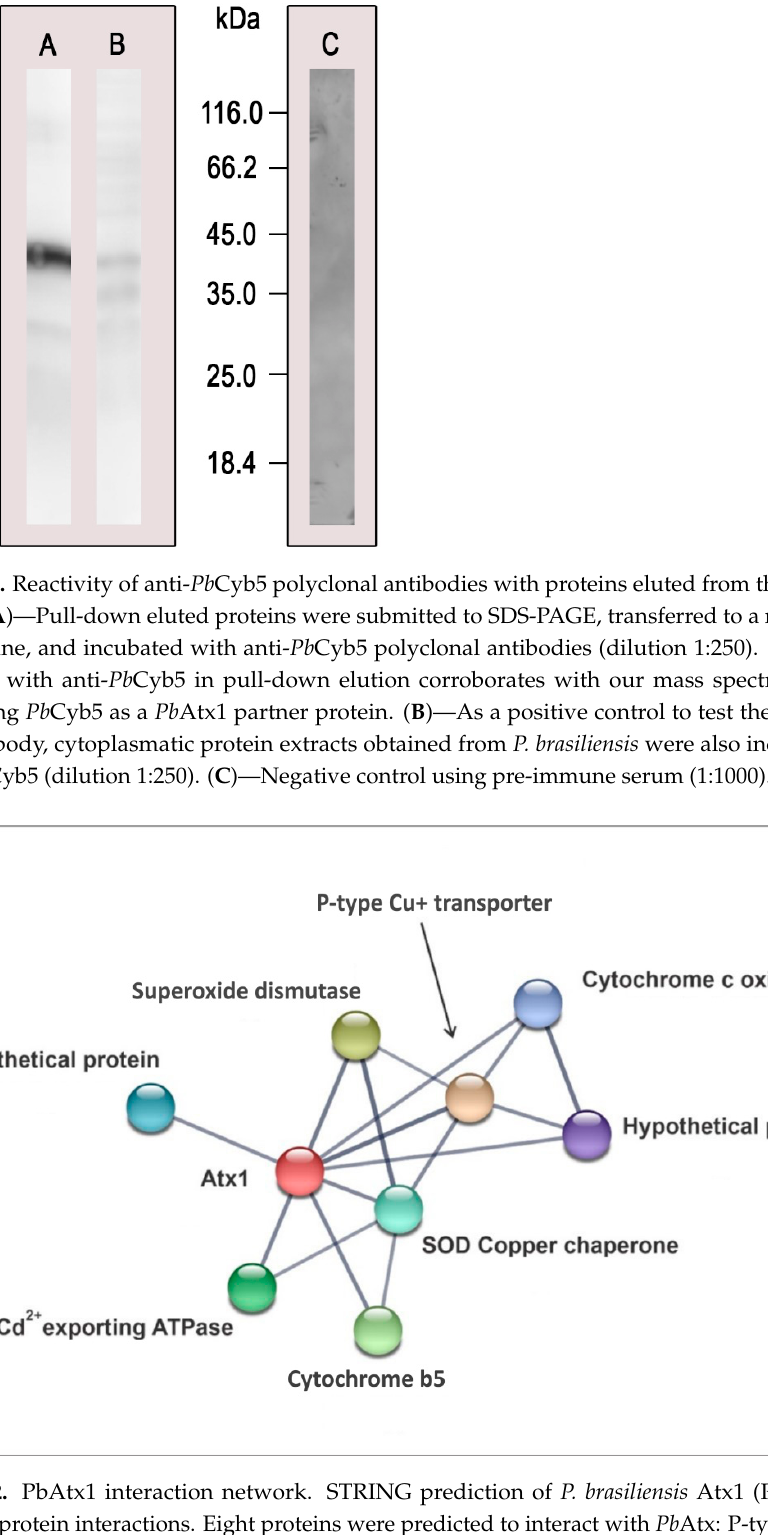
Figure 2. PbAtx1 interaction network. STRING prediction of P. brasiliensis Atx1 (PADG_02352) protein–protein interactions. Eight proteins were predicted to interact with Pb Atx: P-type Cu+ trans- porter (PADG_01582), Cytochrome c oxidase (PADG_07058), Hypothetical protein (PADG_04769); Copper Chaperone for Superoxide dismutase (PADG_01400), Cytochrome b5 (PADG_03559), Cd 2+ - exporting ATPase (PADG_03376), Superoxide dismutase (Cu-Zn) (PADG_07418), and Hypothetical protein